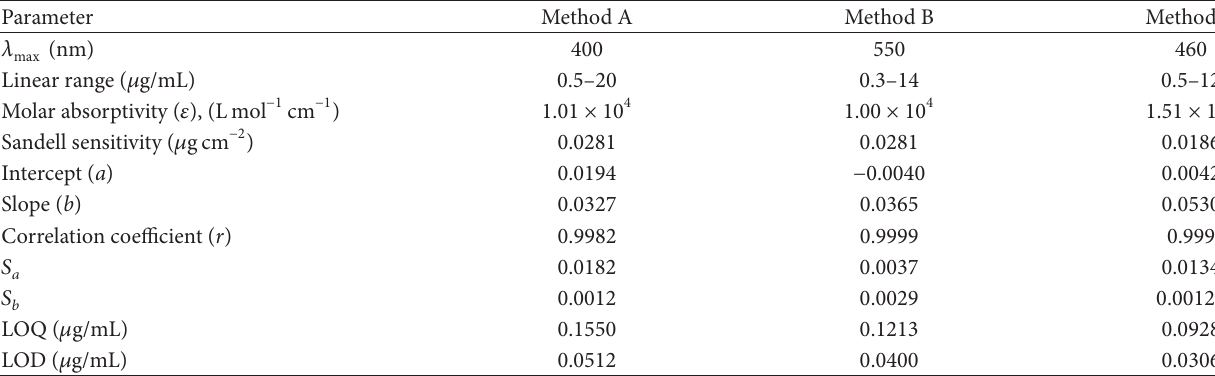
T 1: Optical characteristics and